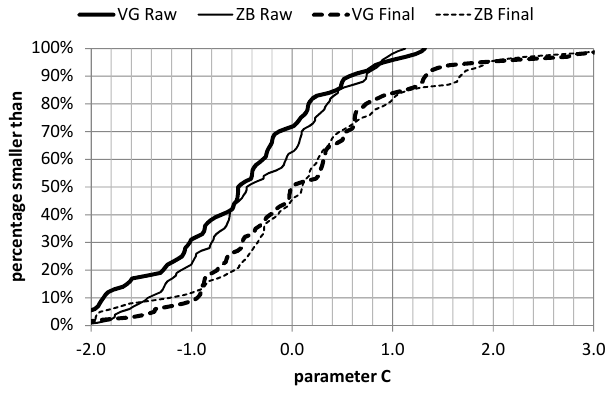
Figure 9. The cumulative distribution of model parameter C